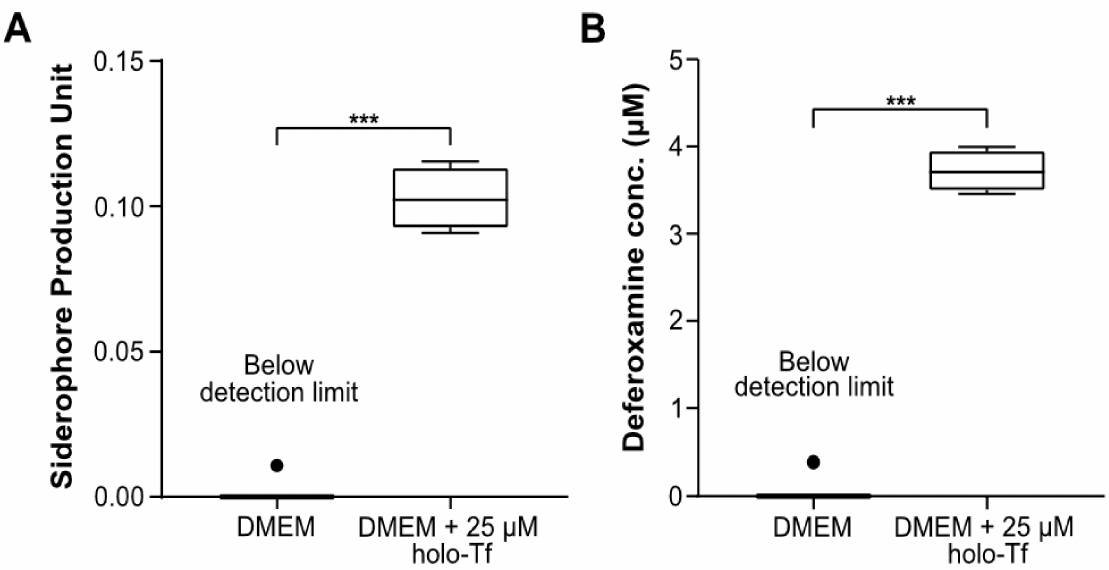
Figure 1. Quantification of siderophores produced by Magnetospirillum magneticum AMB-1 and analysis of their interaction with human transferrin (Tf). ( A ) Siderophores produced by AMB-1 were quantified by a Chrome Azurol S (CAS) assay in DMEM (condition 1) and DMEM supplemented with 25 µ M holo-transferrin (holo-Tf) (condition 2) ( n = 4 per condition, statistical significance was assessed with an unpaired two-tailed t -test, *** p -value < 0.001) ( B ) Siderophore production units plotted in terms of the inferred equivalent concentration of deferoxamine (DFO) ( n = 4 per condition, statistical significance was assessed with an unpaired two-tailed t -test, *** p -value <